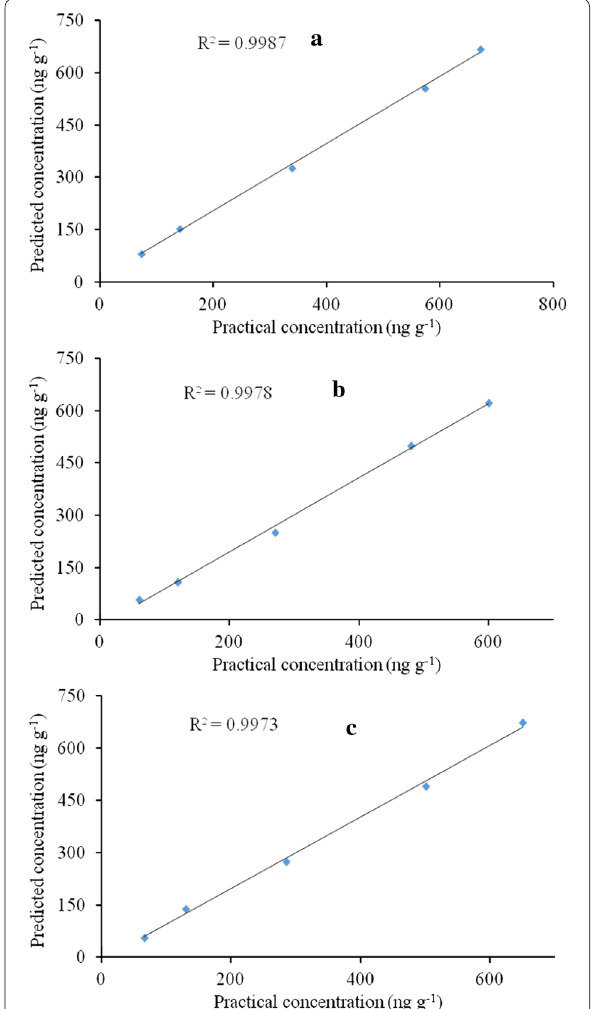
Fig. 1 The predicted concentration derived by n-PLS versus practical concentrations for a oleic acid-CdS/ZnS QDs, b PEG-COOH-CdS/ZnS QDs and c MPA-COOH-CdS/ZnS QDs located on mangrove ( Kandelia obovata (S., L.) Yong) root